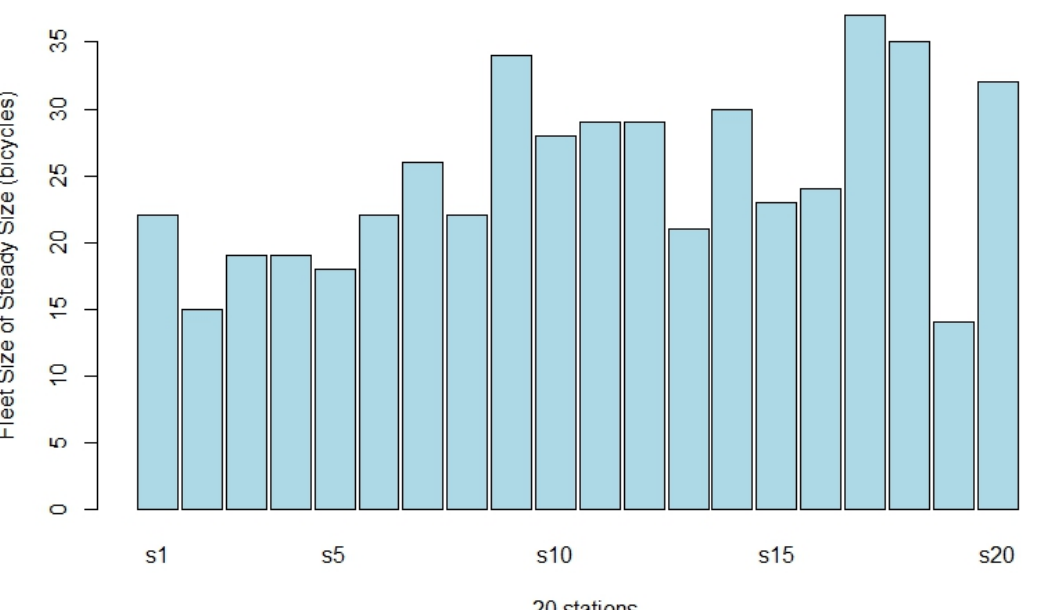
Figure 5. Statistical diagram of steady-state fleet size vector for dockless bike-sharing stations.